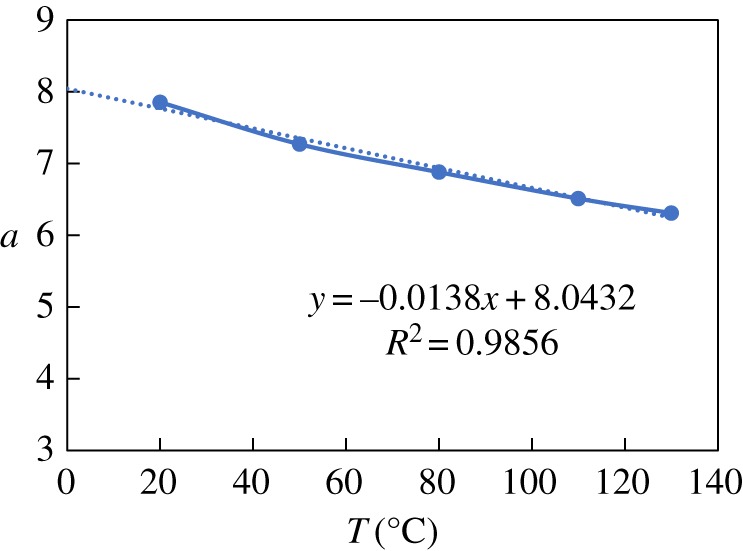
Fitting of constant a1 and temperature.